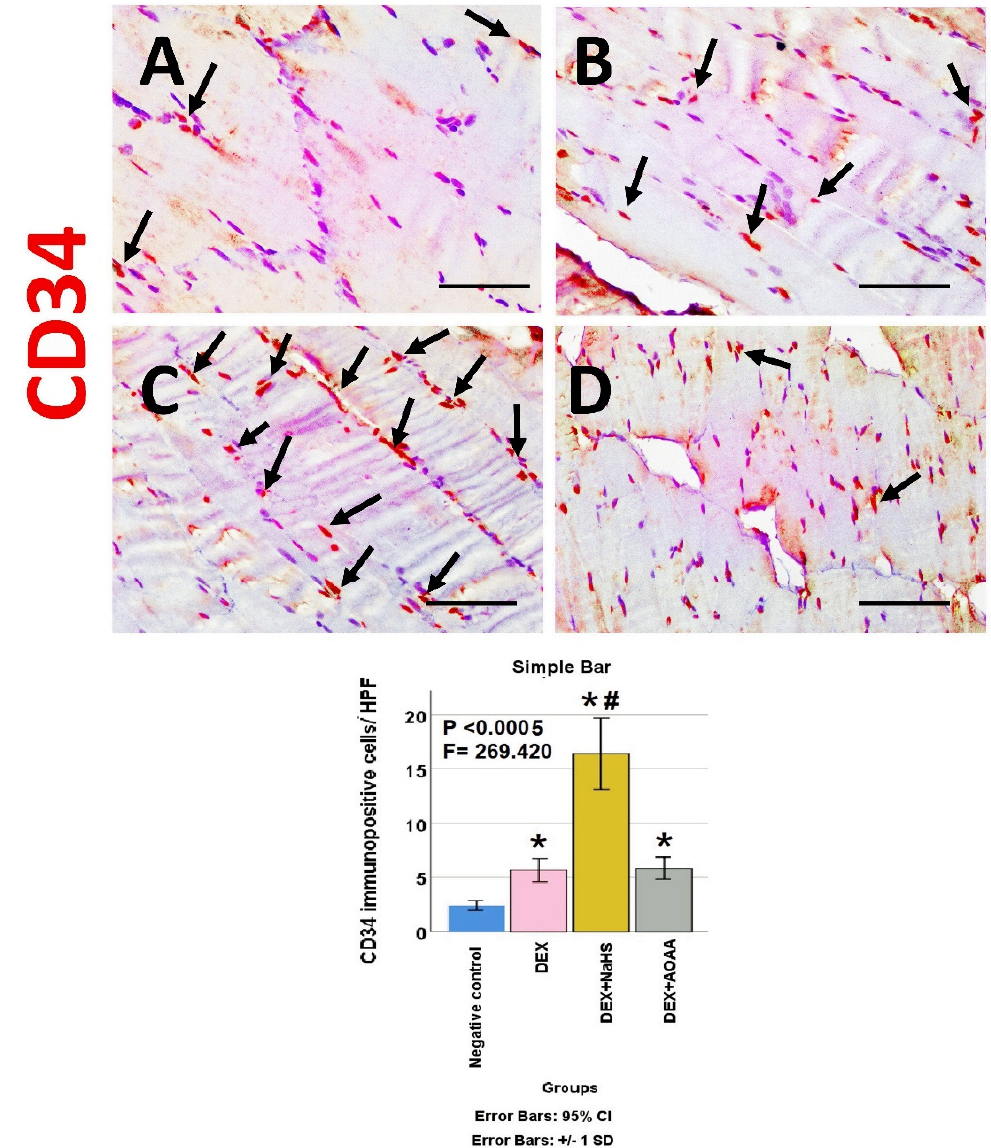
Figure 5. ( A – D ): Light-microscopic image of CD34 immunopositive staining ( × 400) in soleus muscle tissues of all experimental groups; Negative control, Dex, Dex + NaHS, and Dex + AOAA groups ( A – D ; respectively). Scale bar = 25 µ m. Arrows: CD34 immunopositive cells. ( E ) Morphometric analysis of the mean of the number of CD34 immunopositive cells/HPF in the studied